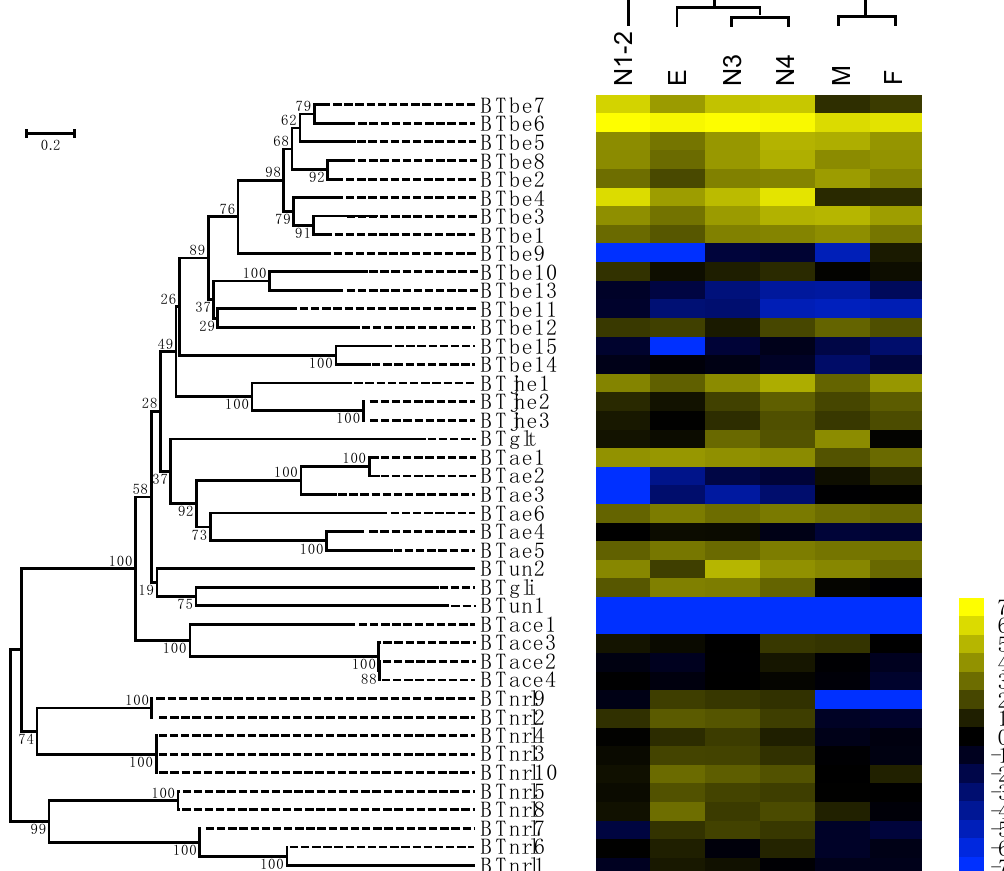
Figure 2. Expression of COE genes among B. tabaci MED developmental stages. The phylogenetic tree on the left shows the phylogenetic relationships of COE in B. tabaci MED. A total of 42 COE amino acid sequences of B. tabaci MED were aligned by MUSCLE, and the phylogenetic tree was constructed by MEGA 6.0 using the NJ method based on the JTT model with a uniform substitution rate. Bootstrap values displayed at branch points are expressed as percentages of 1000 replicates. The color scale is displayed on the right side; yellow represents higher expression values (log2-transformed FPKM values), while blue represents lower expression values (log2-transformed FPKM values). E, Egg; N1-2, 1st- and 2nd-instar nymphs; N3, 3rd-instar nymph; N4, 4th-instar nymph; M, Male; F,